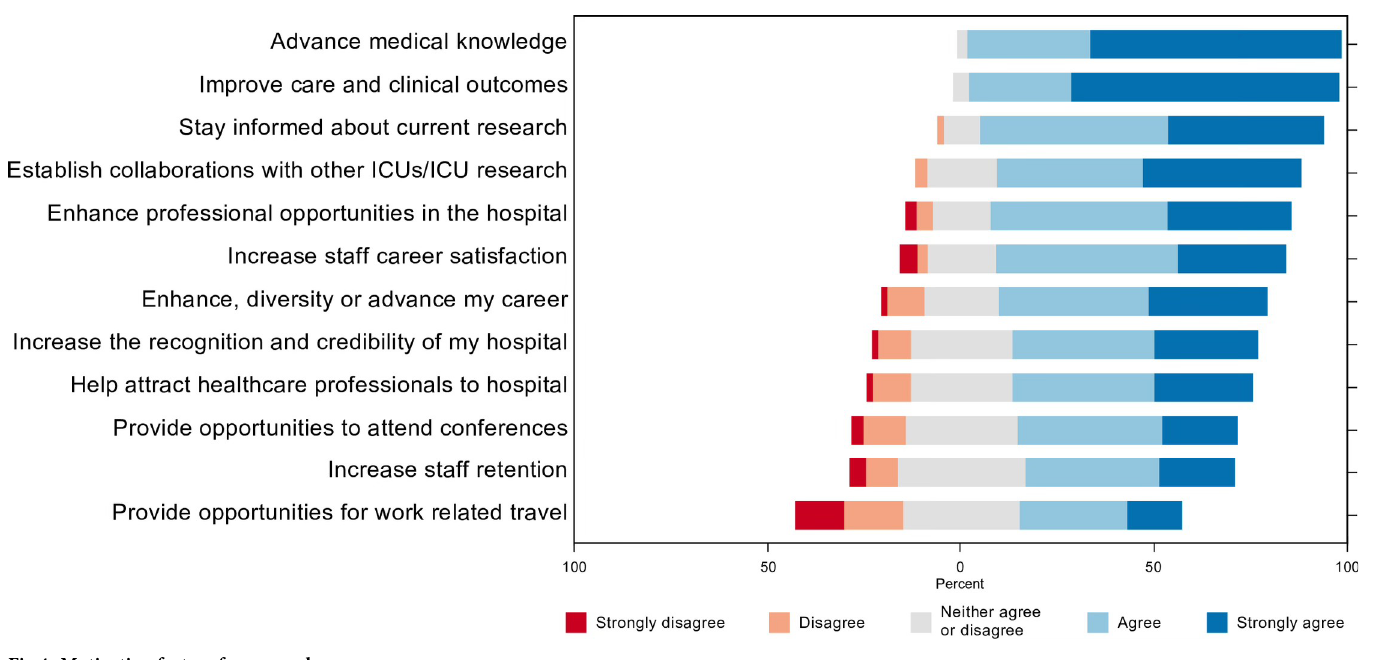
Fig 4. Motivating factors for